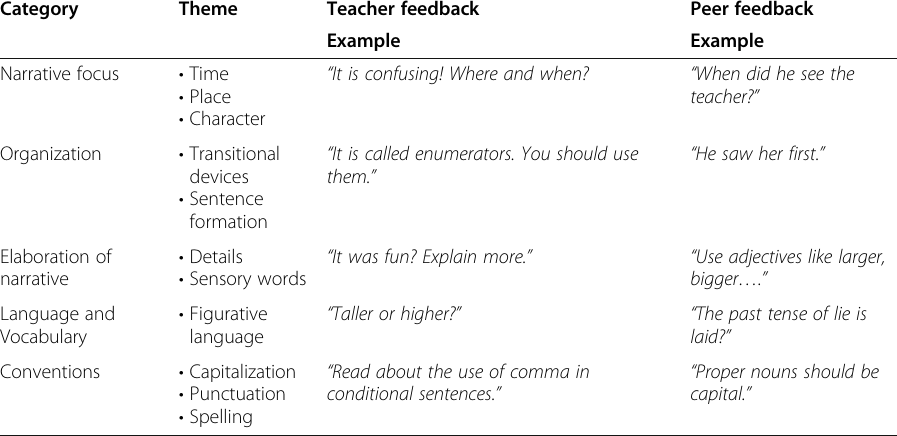
Table 4 The analytical scheme for classifying TA and PA on narrative writing tasks Category Theme Teacher feedback Peer feedback Example